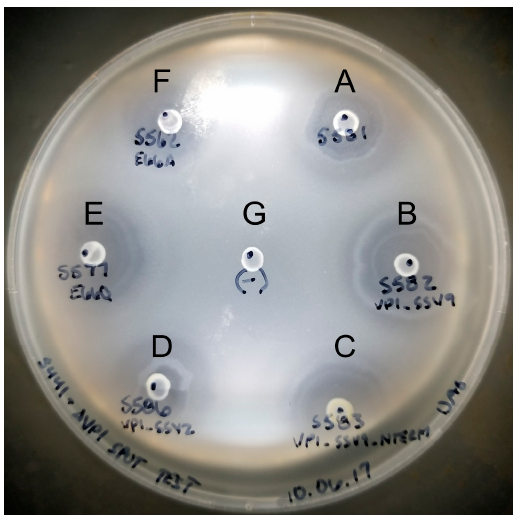
Figure 2. Spot on lawn “halo” assays for functional SSV1 VP1 mutants. Sulfolobus cultures infected with SSV1 containing various VP1 mutations were spotted on a lawn of uninfected Sulfolobus . The lawn and infected cultures were allowed to grow for 48 hours and then photographed. Letters indicate indicates a spotted culture of Sulfolobus infected with a SSV1 that contains the wild type VP1 gene ( A ); the VP1 gene from SSV9 ( B ); a fusion between the N-terminus of VP1 from SSV9 and the C-terminus of VP1 from SSV1 ( C ) the VP1 gene from SSV2 ( D ); a glutamine at position 66 in the SSV1 VP1 protein instead of the wild type glutamate ( E ), or an alanine at position 66 in the SSV1 VP1 protein instead of the wild type glutamate ( F ); ( G ) indicates an uninfected control culture spotted on the lawn.